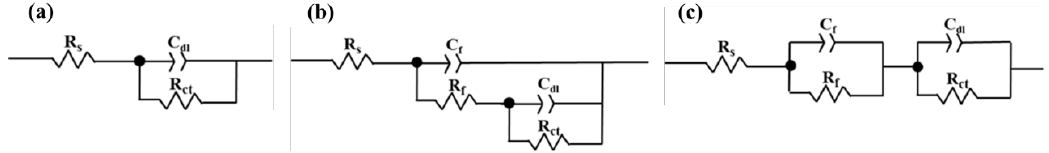
Figure 4. Equivalent electric circuits used to extract parameters from the EIS spectra. ( a ) SG + CaCl 2 ; ( b ) SG + Na 2 CO 3 ; ( c ) SG + Na 2 SiO 3 . (R s : electrolyte resistance; R ct : charge-transfer resistance; R f : film resistance; C dl : double layer capacitance; C f : film capacitance).